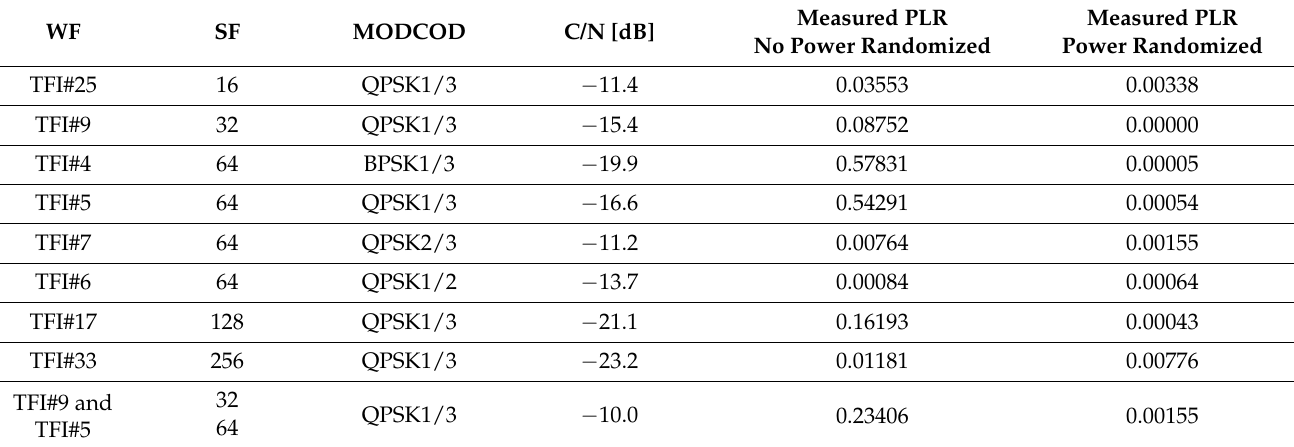
Table 3. Measured PLR comparison with or without power